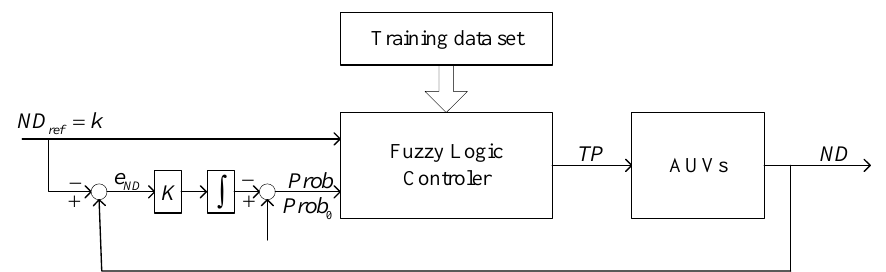
Figure 10. The fuzzy-logic topology control (FTC) scheme.